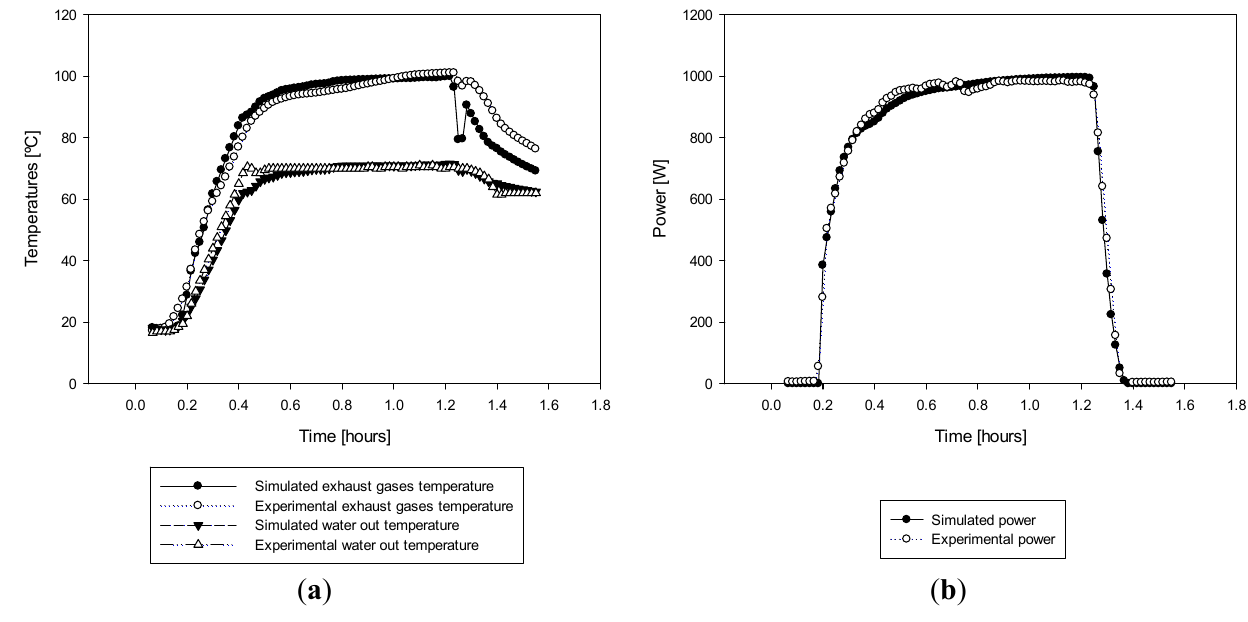
Figure 13. ( a ) Simulated and experimental outlet water temperature and exhaust gases temperature for T = 60 °C; ( b ) Simulated and experimental power for T set capacitance and heat transfer coefficient values are given in Table 1 (last column).